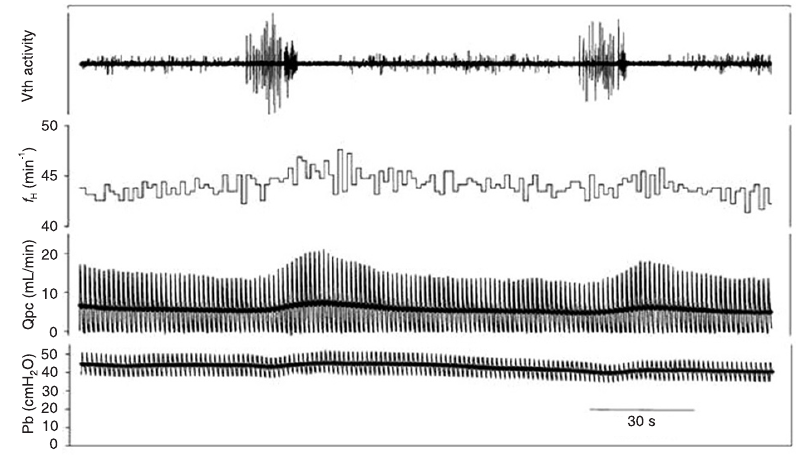
Figure 2. Cardiovascular changes associated with discontinuous ventilatory activity in a decerebrated and paralysed toad ( Bufo marinus ). Ventilatory activity was measured as nervous activity in the fifth cranial nerve, which innervates the respiratory muscles in the buccal cavity. As the toad was unidirectionally ventilated and paralysed, there were no changes in afferent input during bouts of fictive ventilation, and the rise in pulmocuta - neous blood flow (Qpc) during ventilation is likely to be caused by central feed-forward mechanisms. There were no obvious changes in systemic blood pressure (Pb) or heart rate ( f H ) (Modified from Ref. 53, with